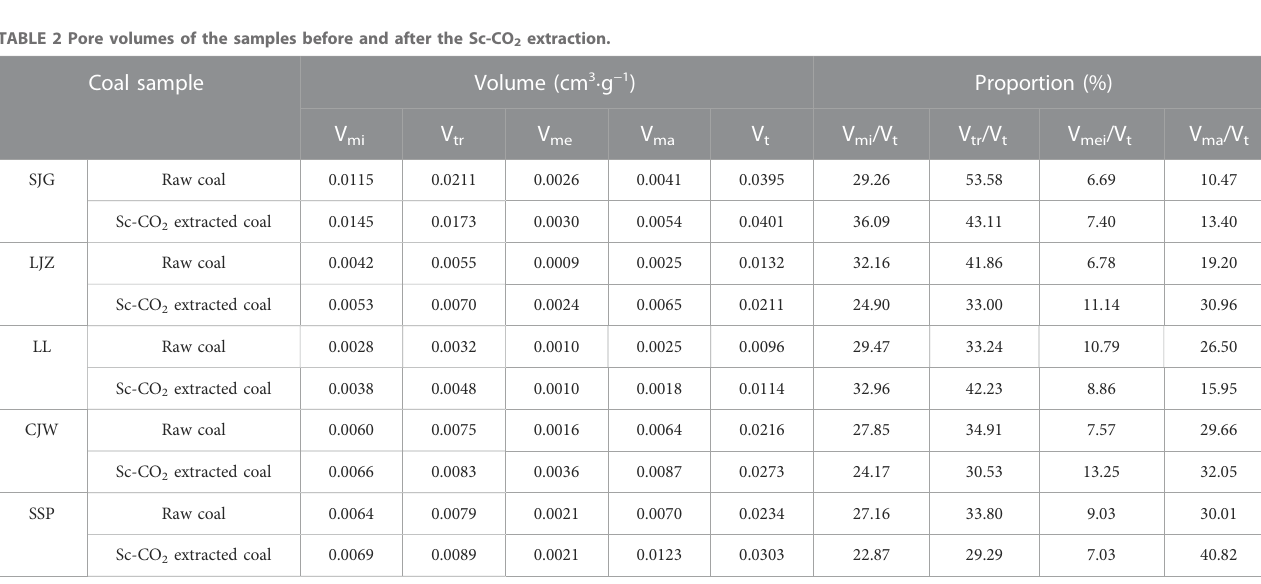
fl owmeter; (Q) Check 2